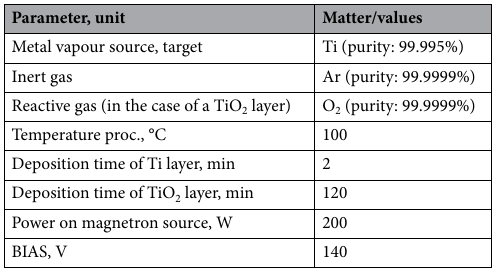
Table 1. Conditions of deposition of MS-PVD layers.